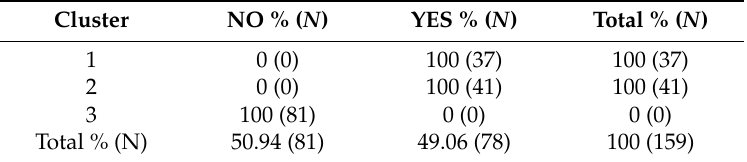
Table 2. Percentages of individuals with clinically relevant binge eating behaviors as for each cluster.